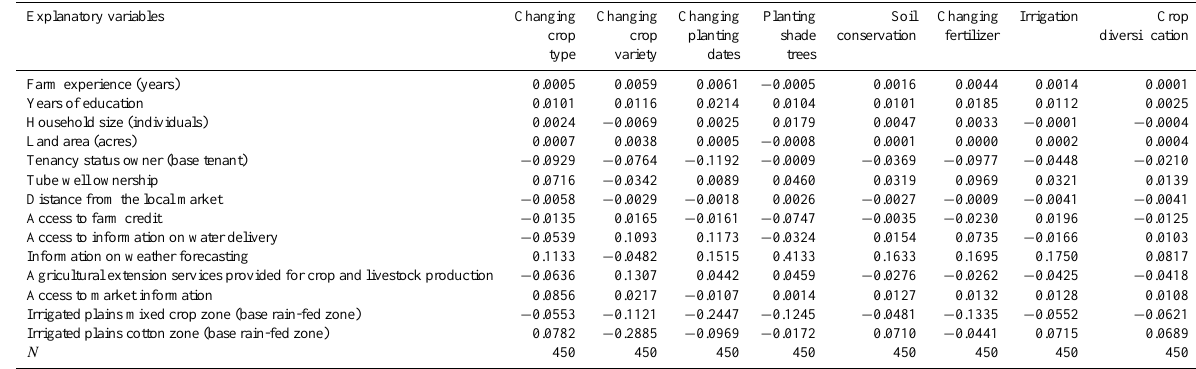
Table 5. Marginal effects from the binary logistic models of farm-level adaptation